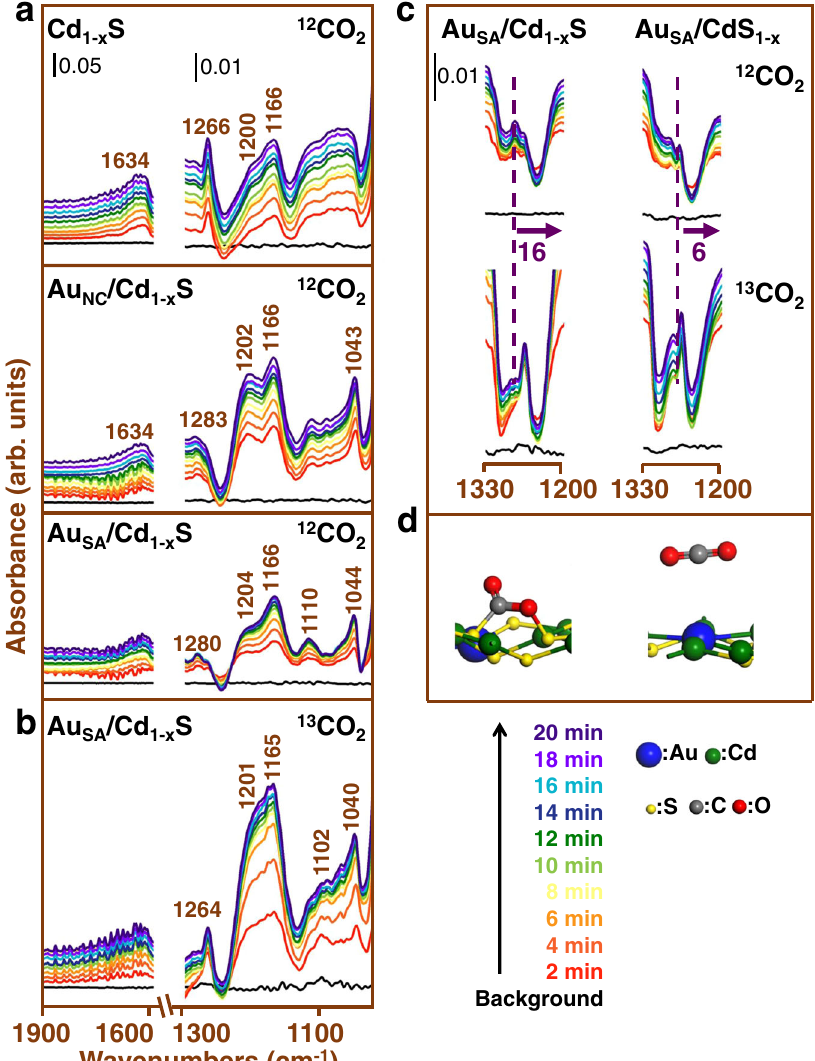
Fig. 4 In situ DRIFTS measurement. a In situ DRIFTS spectra of the 12 CO 2 adsorption process over Cd 1-x S, Au NC /Cd 1-x S, and Au SA /Cd 1-x S. b In situ DRIFTS spectra of the 13 CO 2 adsorption process over Au SA /Cd 1-x S. c The comparison between in situ DRIFTS spectra of 12 CO 2 and 13 CO 2 adsorption process over Au SA /Cd 1-x S and Au SA /CdS 1-x . d The adsorption models of CO 2 on different surfaces on single Au atom in Au SA /CdS 1-x and on Cd vacancy in Au SA /Cd 1-x